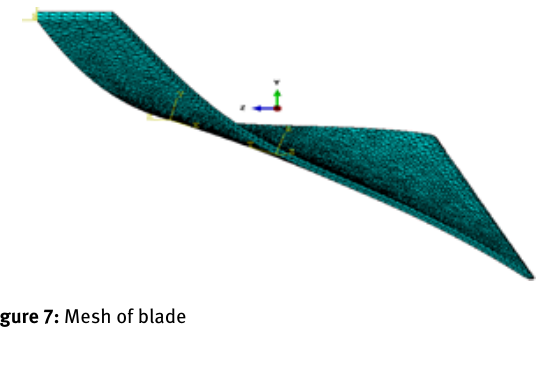
Figure 7: Mesh of